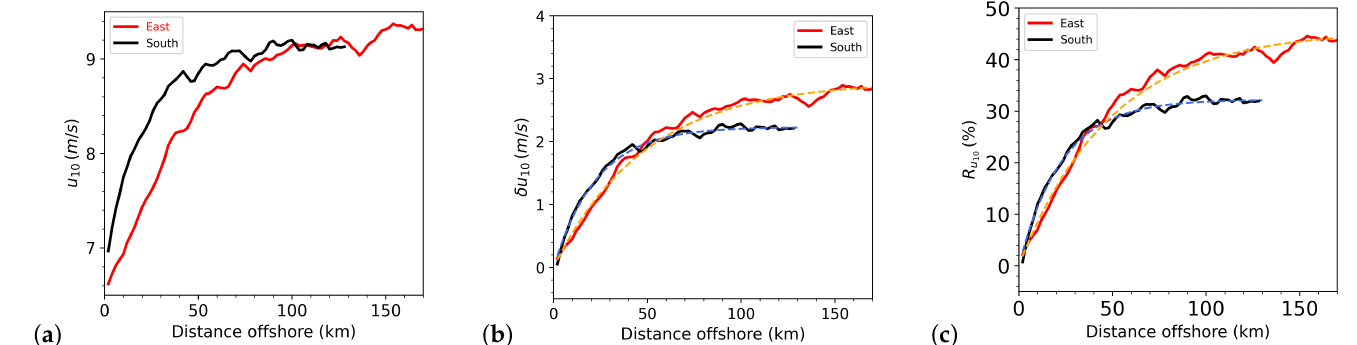
Figure 11. ( a – c ): Comparison of absolute wind speed ( a ), wind speed increase ( b ) and normalised wind speed increase ( c ) for easterly (red) and southerly (black) winds for “INCS” class. The blue and orange dashed lines in ( b , c ) refer to the fitted empirical